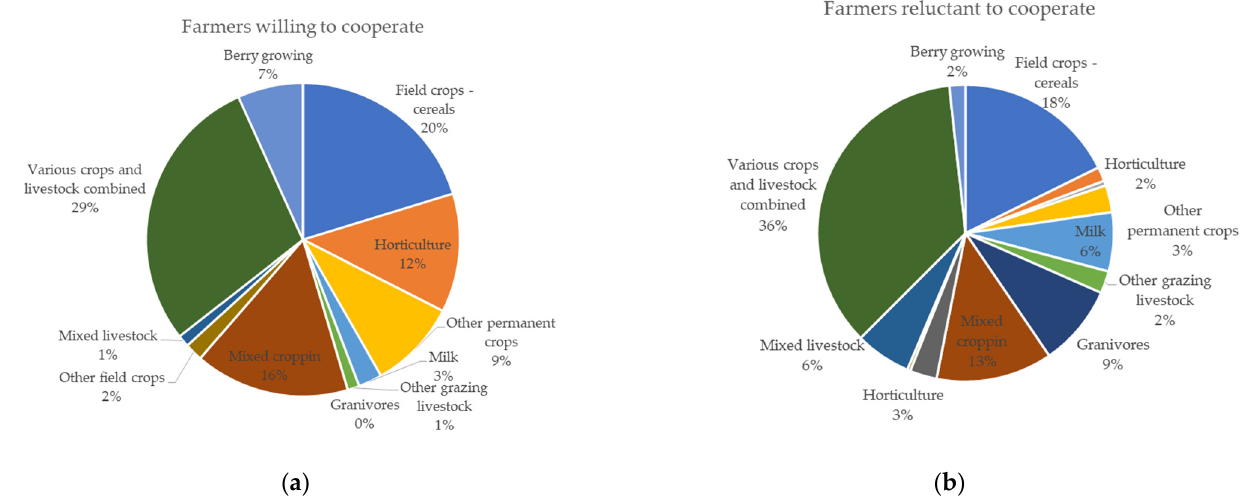
Figure 9. Farming types of the groups of small-scale farms willing to cooperate ( a ) and reluctant to cooperate ( b ) (N = 1002).